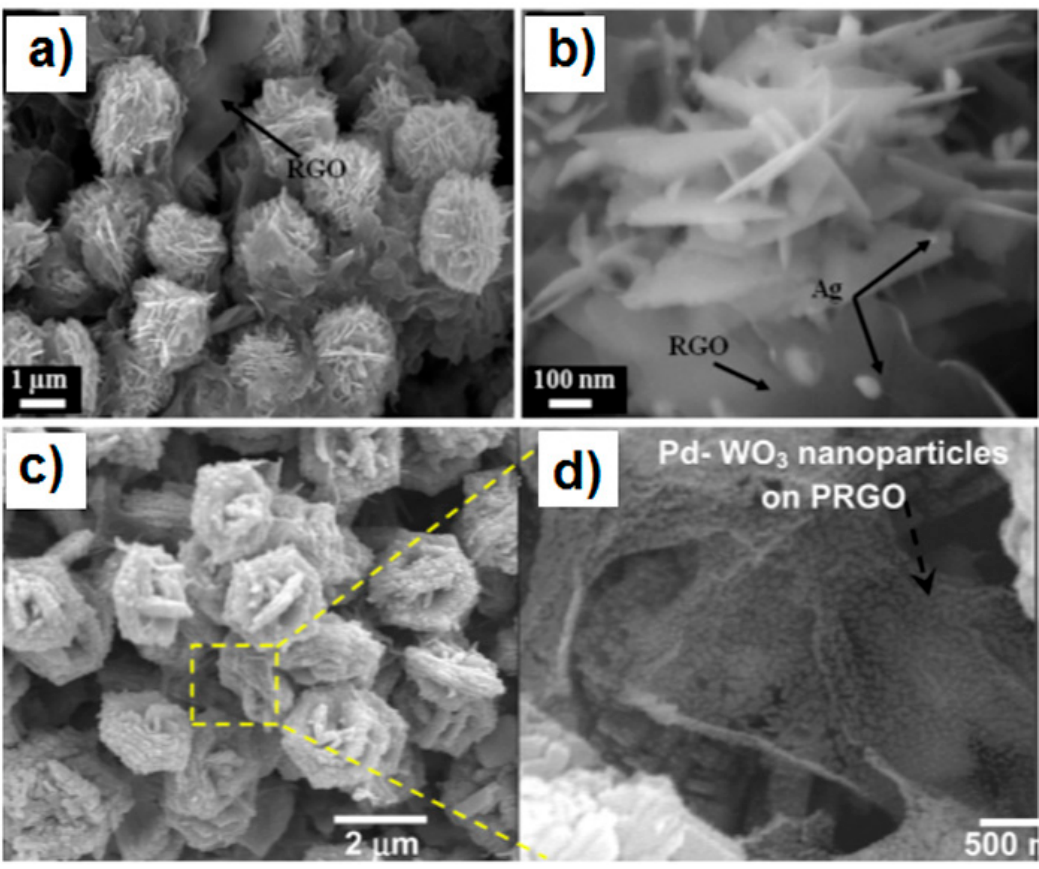
Figure 8. Morphology of ( a,b ) Ag-loaded 3D ZnO nanostructure-rGO [93]; ( c,d ) 3D rGO-In 2 O 3 composite [94]. Reproduced with permission from [93,94], © 2015 and 2014 Elsevier.